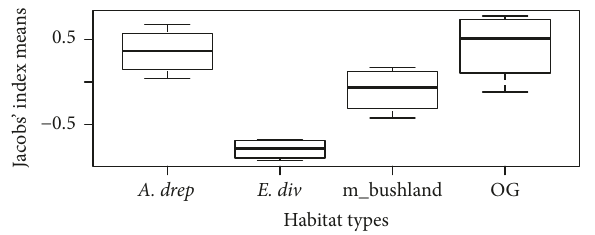
Figure 5: Jacobs index means for all guilds across the habitat types.